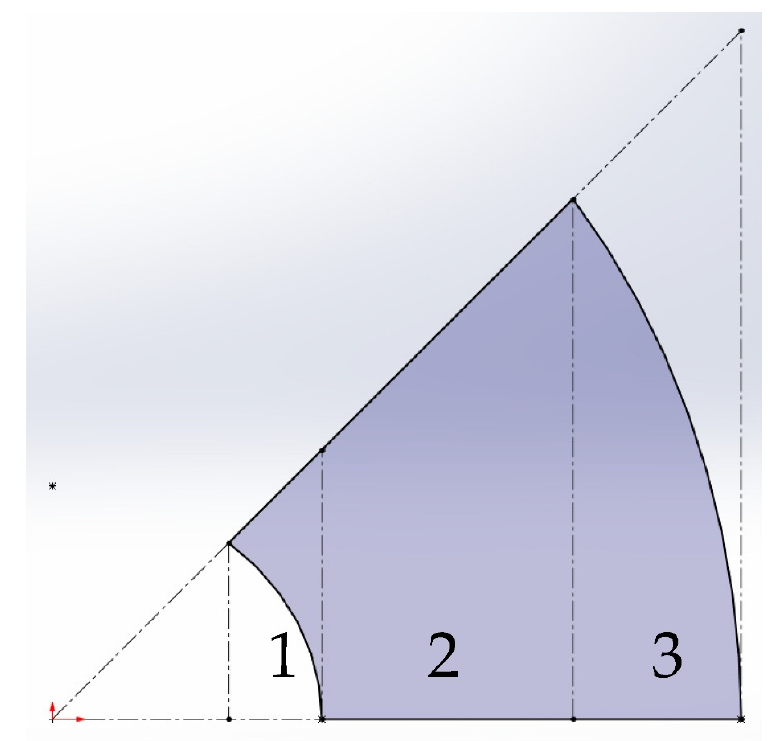
Figure 8. Representation of the half cross section ant the integration sectors.